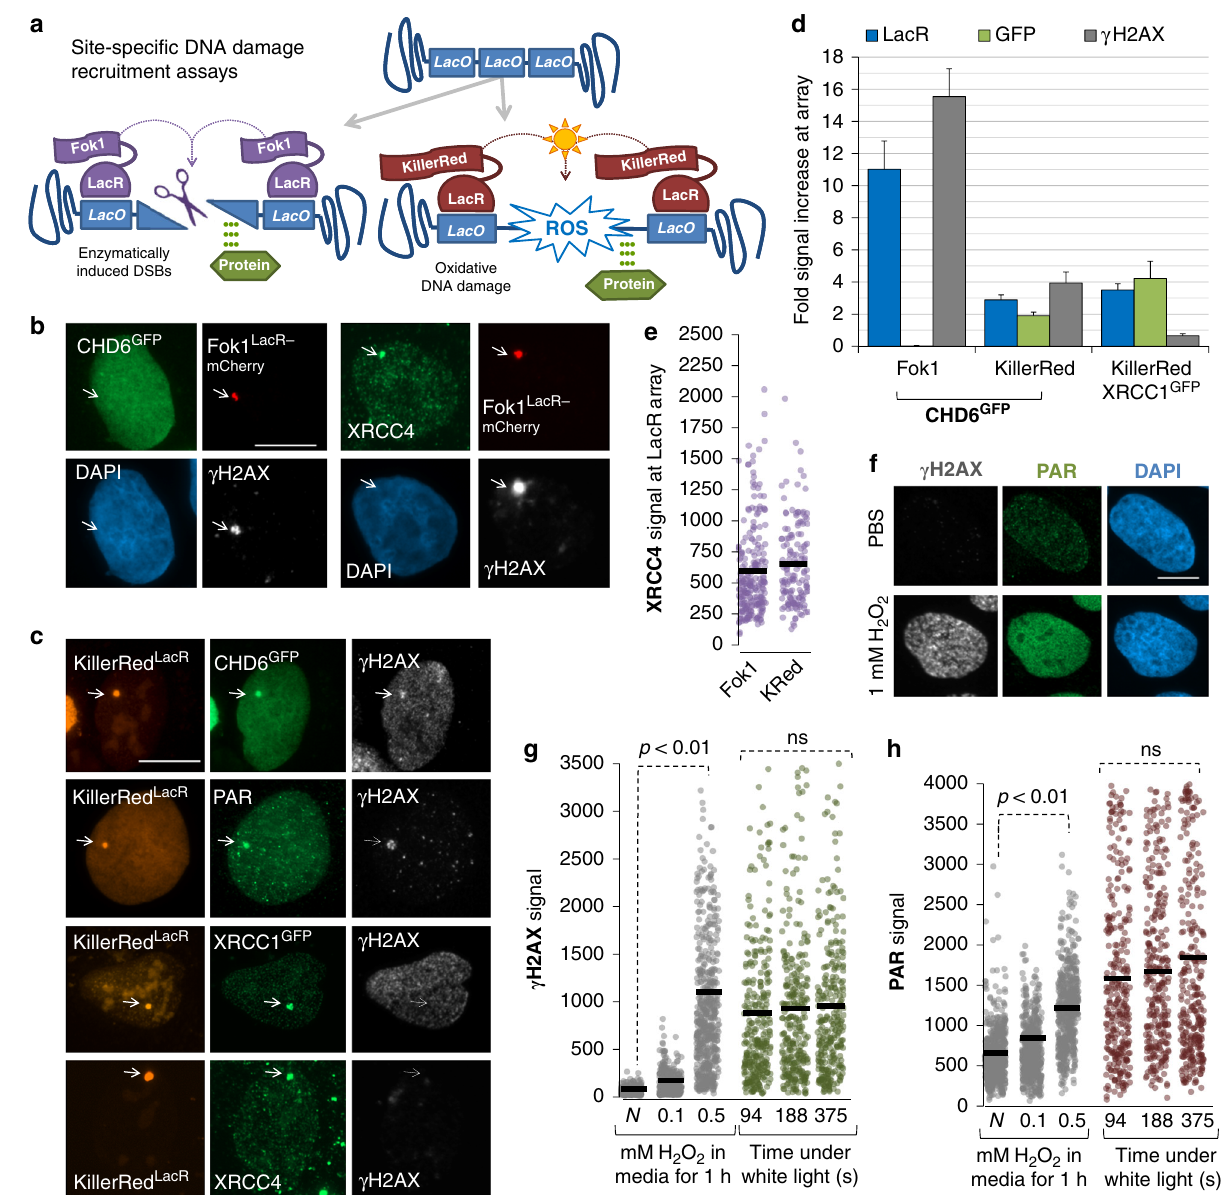
Fig. 2 CHD6 is recruited selectively to oxidative lesions. a Schematic of site-speci fi c DNA damage recruitment assay. b , c Fok1 or KillerRed expression was induced in U2OS 2-6-3 cells (transiently expressing CHD6 GFP , XRCC1 GFP or neither) then immunostained with γ H2AX, PAR and/or XRCC4 and imaged. d , e The fold increase in γ H2AX, LacR, XRCC4, XRCC1 and/or GFP signal in cells from ( b , c ) was quanti fi ed. Error bars = s.e.m.; n = 3. e – h U2OS 2-6-3 cells were exposed to 1 mM H 2 O 2 in media for 1 h, immunostained and imaged for nuclear γ H2AX and PAR signal and compared to KillerRed expressing cells stimulated with 94 – 375 s of white light. P values are for Student ’ s t -test. All scale bars equal 5 µ or truncation mutations without perturbing nuclear localization in cells treated with PARG inhibitors (PARGi) or PARG siRNA, (Fig. 3d, Supplementary Fig. 1h). Ablation of a conserved catalytic suggesting that CHD6 binds to PAR directly or to PAR-binding amino acid (K492A) had no impact on CHD6 dynamics (Fig. 3e). proteins (Fig. 3a – c). XRCC1 is a major PAR-binding platform for Introduction of point mutations into highly conserved amino recruiting DNA damage response proteins 28,29 and accumulated acids (F318A, Y322A, Y398A, W402A = Δ CD1 + 2) known to fourfold more than CHD6 at micro-irradiation tracks with dis- ablate CHD enzyme ability to bind methyl-lysine 30,31 perturbed similar recruitment and dispersal kinetics (Fig. 1i). XRCC1 loss by mid-to-late retention at DNA damage, although it had no effect CRISPR/Cas9 (clustered regularly interspaced short palindromic on the early/fast recruitment (Fig. 3e). Deletion of the C-terminal repeats/CRISPR-associated 9)-mediated deletion did not impact BRK domain (1 – 1448) had no effect on CHD6 dynamics, while CHD6 GFP recruitment, suggesting that CHD6 binds to PAR directly or indirectly via an XRCC1-independent process (Sup- additional loss of the SANT domain (1 – 1028) and/or the ATPase/ plementary Fig. 1g). Helicase core (1 – 449) only impacted late retention (Fig. 3e). Further loss of the double chromodomain ablated the later recruitment to DNA damage sites, we introduced multiple point accumulation and retention of CHD6 (1 – 269), suggesting (similar